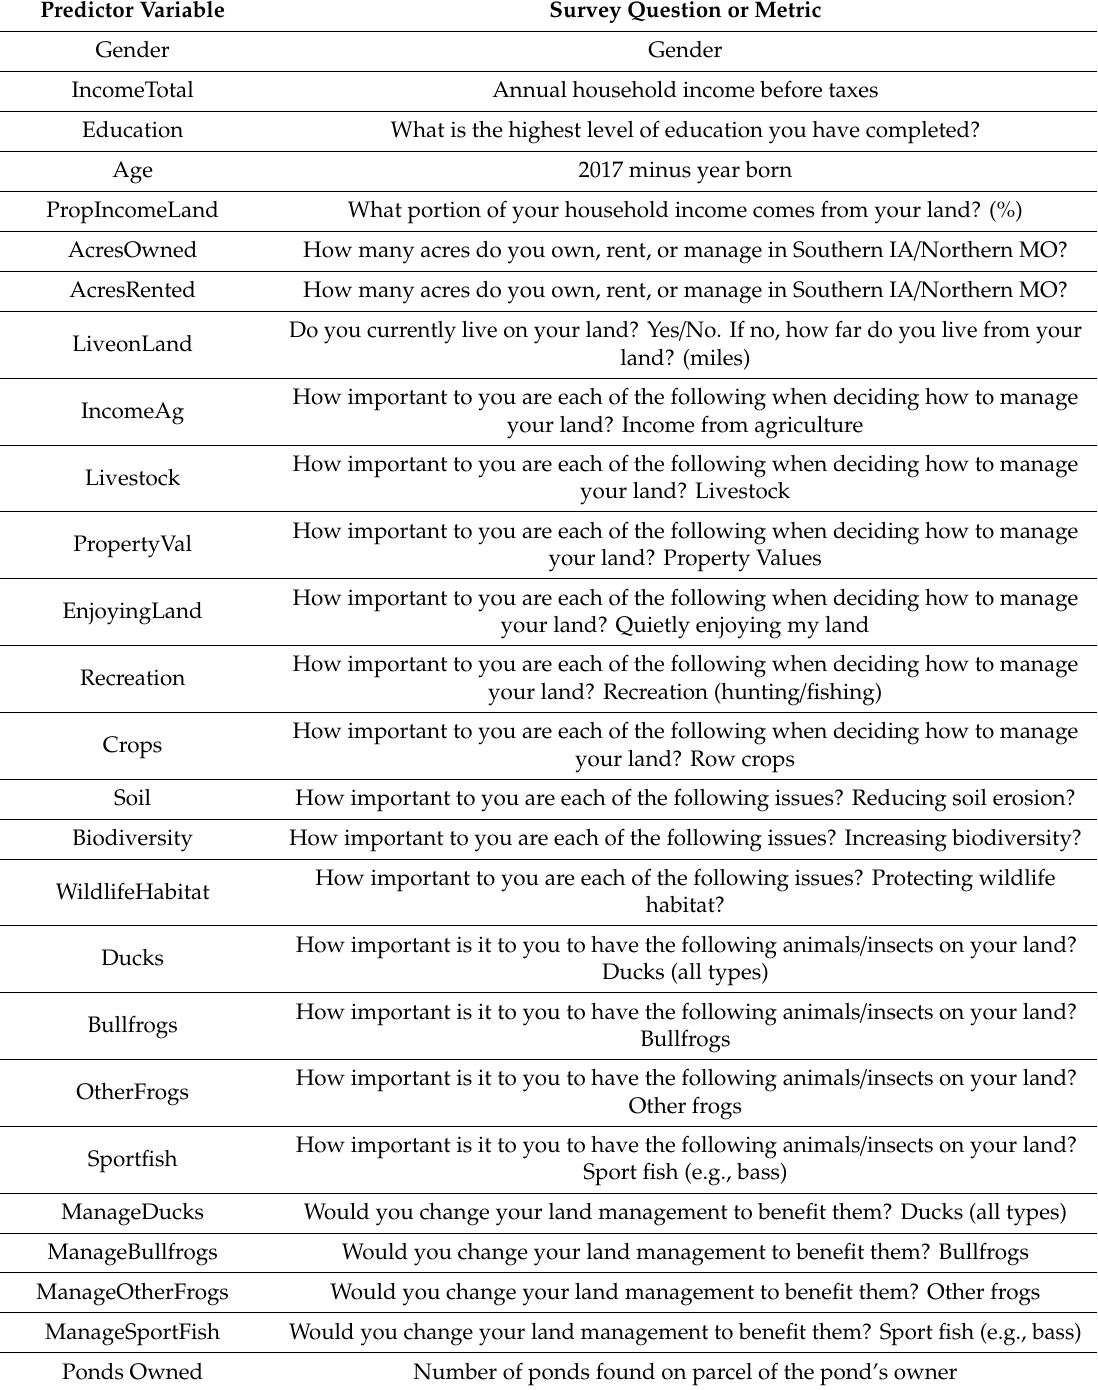
Table 2. Predictor variables from landowner survey used in